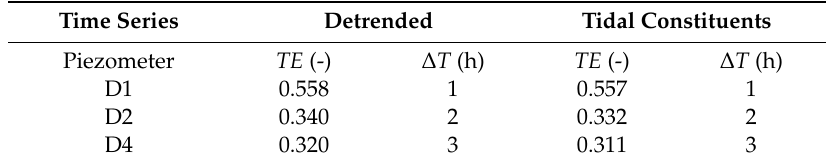
Table 1. Tidal e ffi ciency, TE , and time lag, ∆ T , values determined for detrended signals and signals made of four dominant tidal constituents for the period 1 August to 31 August 2015.